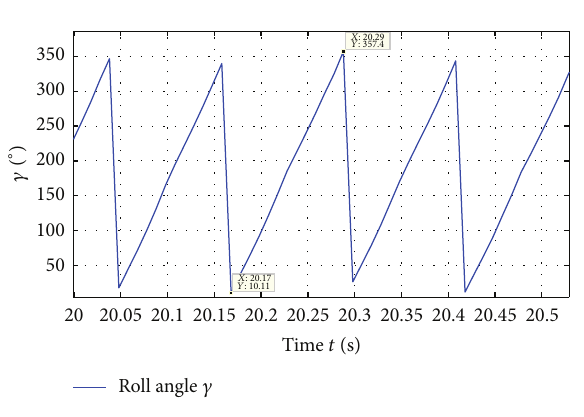
Figure 23: Magnification (after 20 seconds).